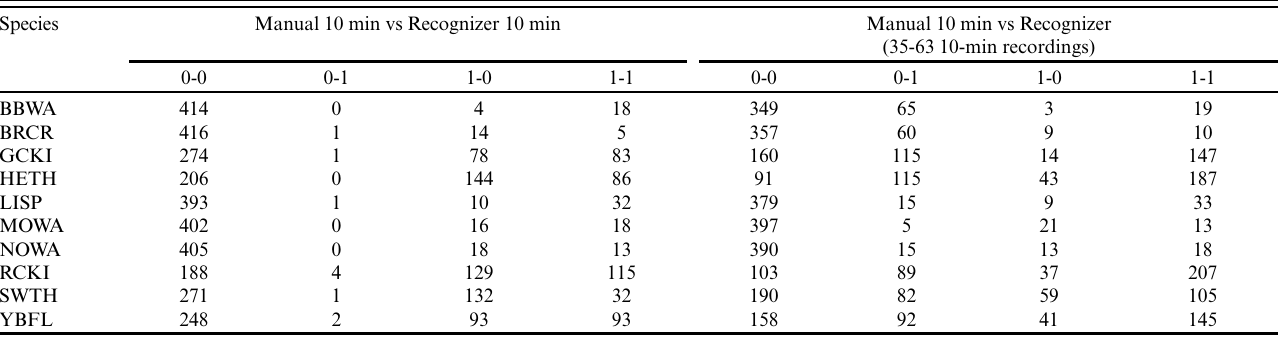
Table 8 . Summary of detection (1) and nondetection (0) patterns by species comparing manual 10-minute approach (a single recoding) to each of recognizer 10-minute approach (a single recording) and recognizer week-long approach (between 35 and 63 10-minute recordings). (0-0 = not detected with either method, 0-1 = not detected with manual approach but detected with recognizer, 1-0 = detected with manual approach but not detected with recognizer, 1-1 = detected with both methods). See Table 4 for species codes. Species